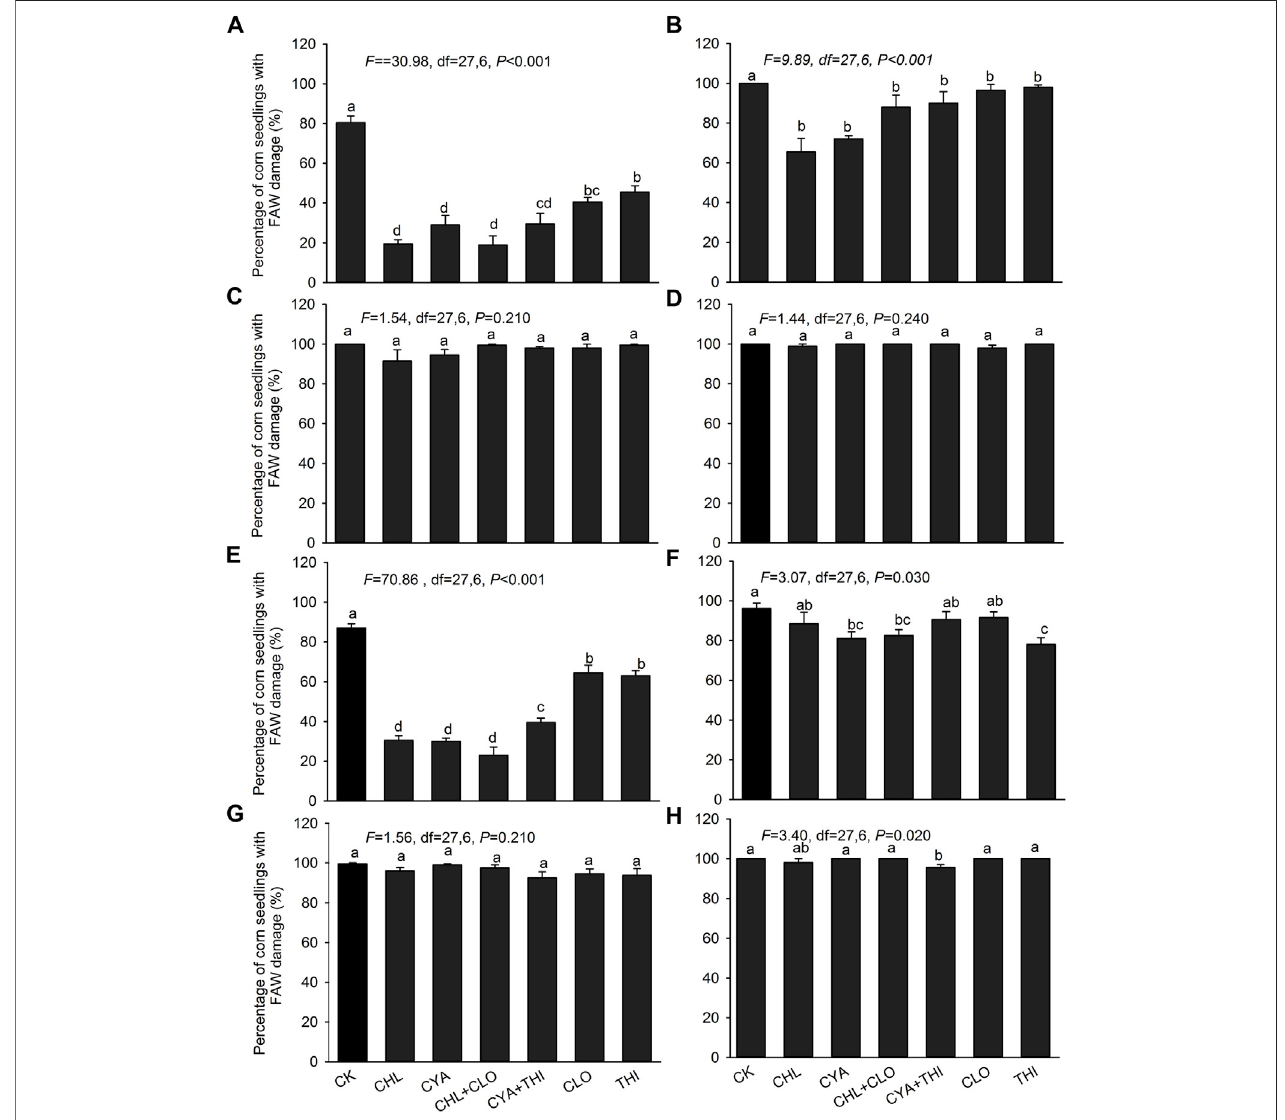
FIGURE 2 | Percentage of corn seedlings damaged by FAW in fi eld experiments corn where seeds were treated with chlorantraniliprole (CHL), cyantraniliprole (CYA), clothianidin (CLO), thiamethoxam (THI), CHL + CLO and CYA + THI; CK is the untreated control. Damage rates (±SE) caused by FAW larvae are shown for July 2021 at 7 panel (A) , 14 (B) , 21 (C) and 28 (D) DAE. Damage rates in September 2021 are shown for 7 panel (E) , 14 (F) , 21 (G) and 28 (H) DAE. Columns labeled with different letters indicate signi fi cant differences among treatments with Tukey ’ s HSD test at p < 0.05.